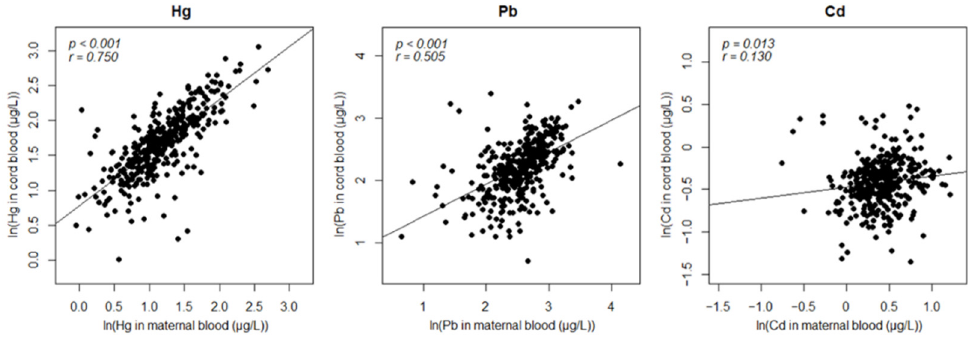
Figure 1. Association between maternal and prenatal heavy metal exposure levels. Table 2. Association between maternal and prenatal exposure and between exposure and gesta- tional age.